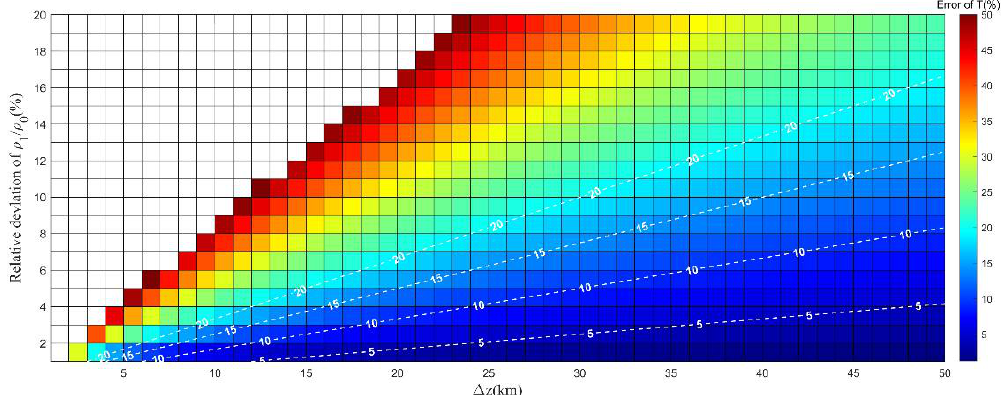
Figure 9. The relationship between the relative errors, wire length and densities’ measurement error. The horizontal axis indicates the wire length, the vertical axis indicates the relative error of ( ρ 1 the color indicates the error of the derived temperatures. The dashed line shows the different error of derived